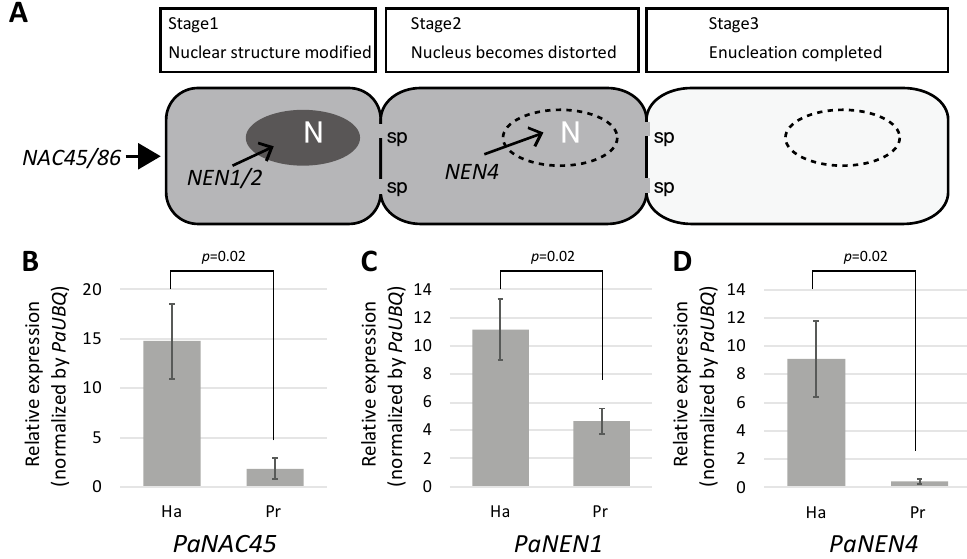
Figure 5. ( A ) Stages of sieve element differentiation. N, nucleus; sp, sieve plate pore. ( B – D ) Relative expression levels of ( B ) PaNAC45 , ( C ) PaNEN1 , and ( D ) PaNEN4 in a surgically separated haustorium (Ha) and protrusion (Pr). Expression levels were normalized to that of Phelipanche aegyptiaca UBIQUITIN ( PaUBQ ). The means and standard deviations of three replicates are presented. NAC = NAC-domain containing transcription factor; NEN = NAC45/86-dependent exonuclease-domain protein.